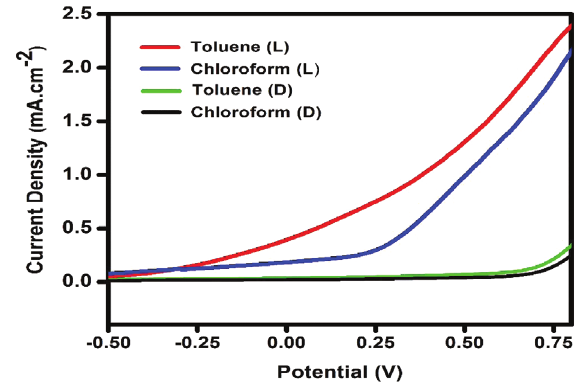
-In S -Bi S 3 2 3 2 3